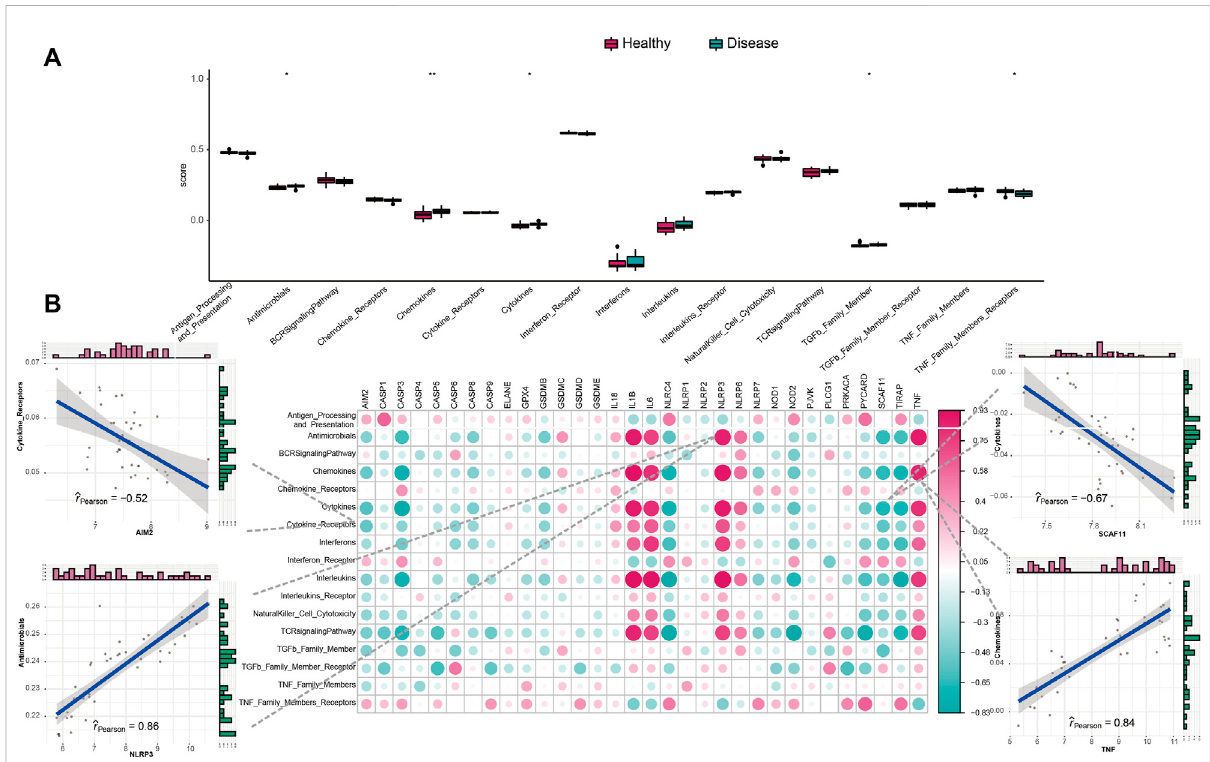
FIGURE 4 Correlationbetweenimmunereactiongenesetsandpyroptosisgenes. (A) Differenceintheactivityofeachimmunereactiongenesetbetween healthy and IS samples. (B) Dot-plot demonstrated the correlations between each dysregulated immune reaction gene set and each